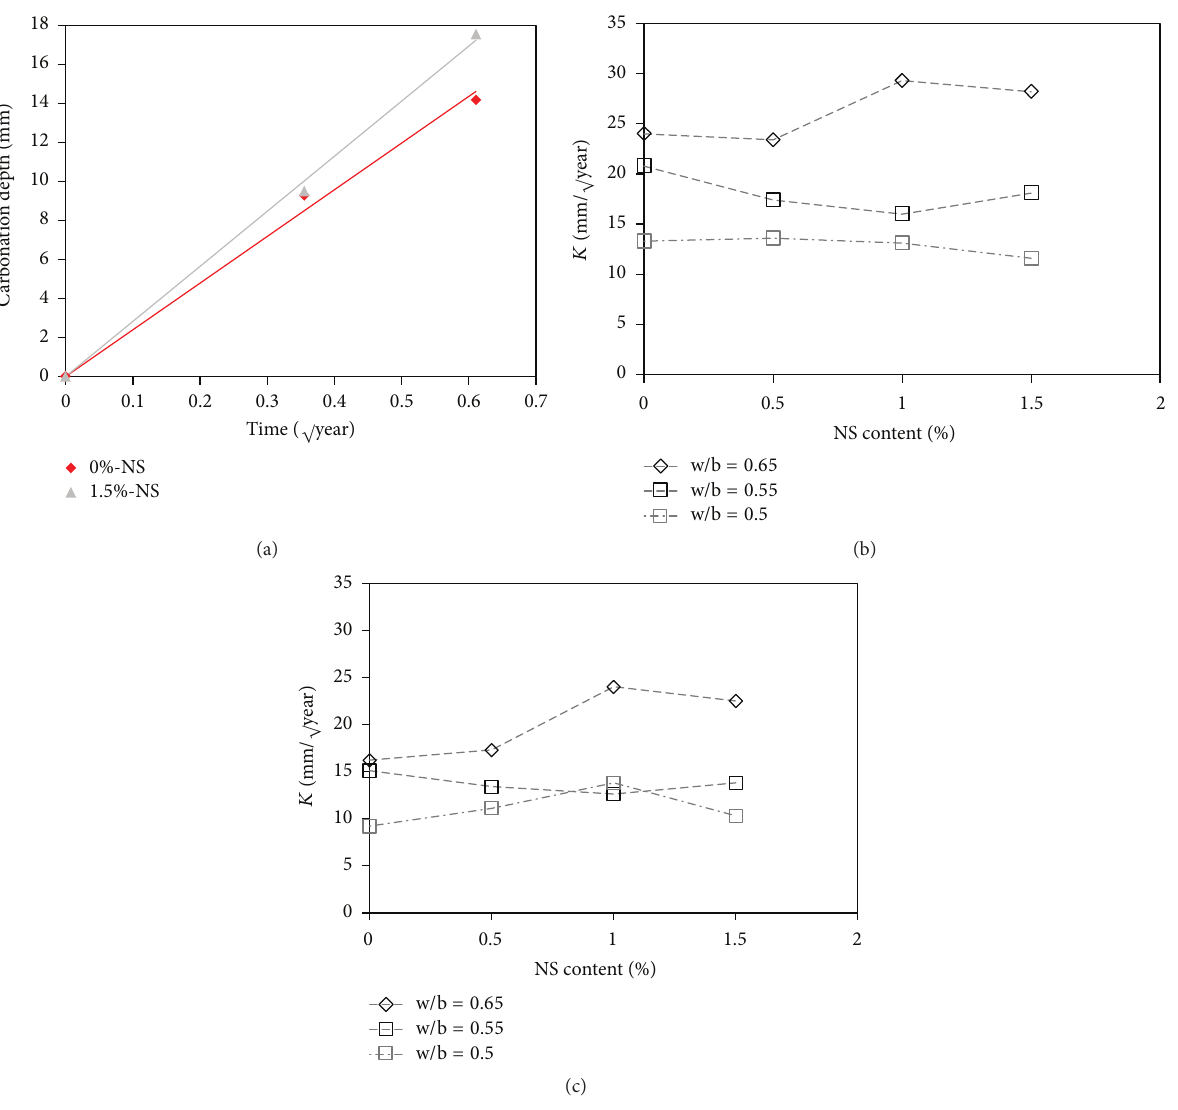
Figure 8: (a) Example of carbonation depth as a function of square root of time of exposure at 4% CO 2 and interpolated lines for trowelled surface of reference and 1.5% addition into concrete with w / b = 0.65 . Carbonation coefficients of (b) trowelled and (c) mould surface of concrete as a function of NS